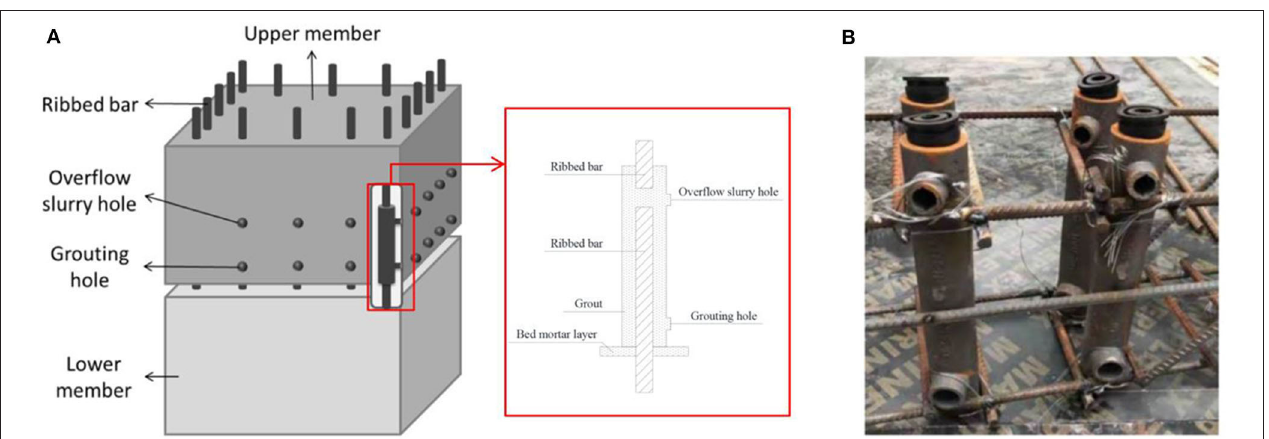
FIGURE 1 | Full grouting sleeve connection. (A) Schematic diagram. (B) Physical diagram.